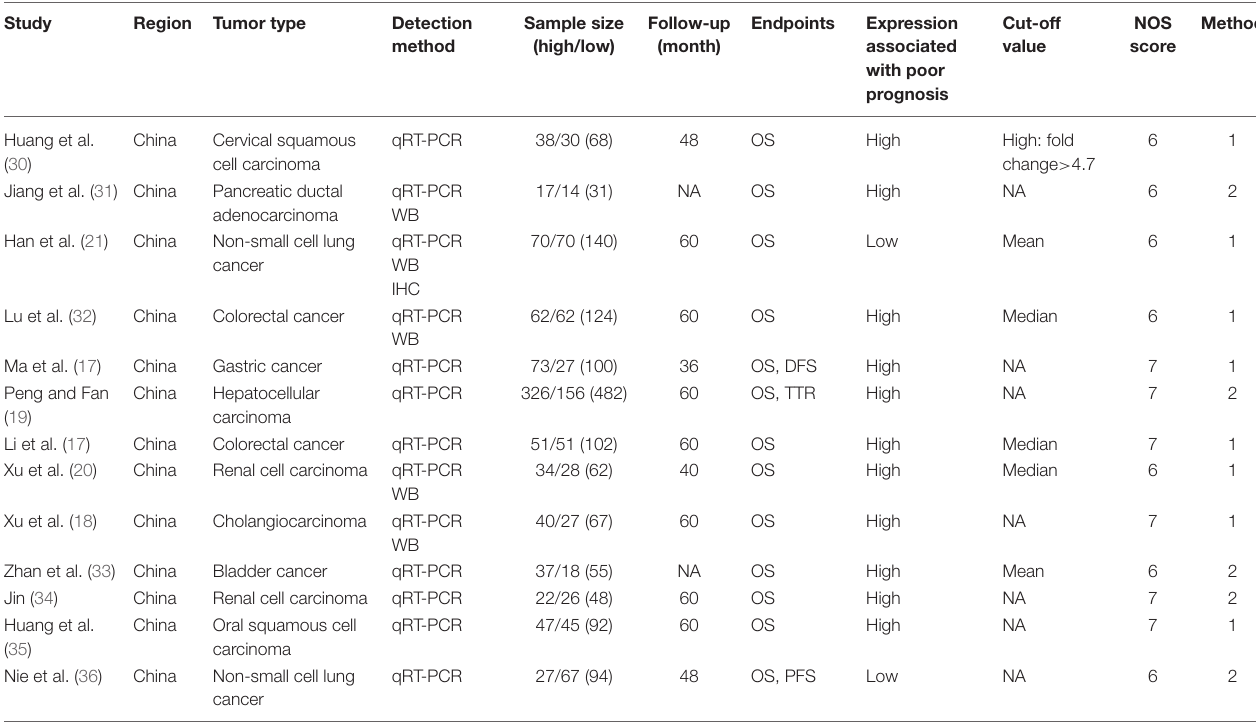
Method:1denotedasobtainingHRsdirectlyfrompublications;2denotedasHRscalculatedfromthetotalnumberofevents,correspondingp-valueanddatafromKaplan–Meiercurves; IHC,immunohistochemistry;PCR,polymerasechainreaction;WB,westernblot;OS,overallsurvival;TTR,timetorecurrence;DFS,disease-freesurvival;NOS,Newcastle–OttawaScale; NA, not